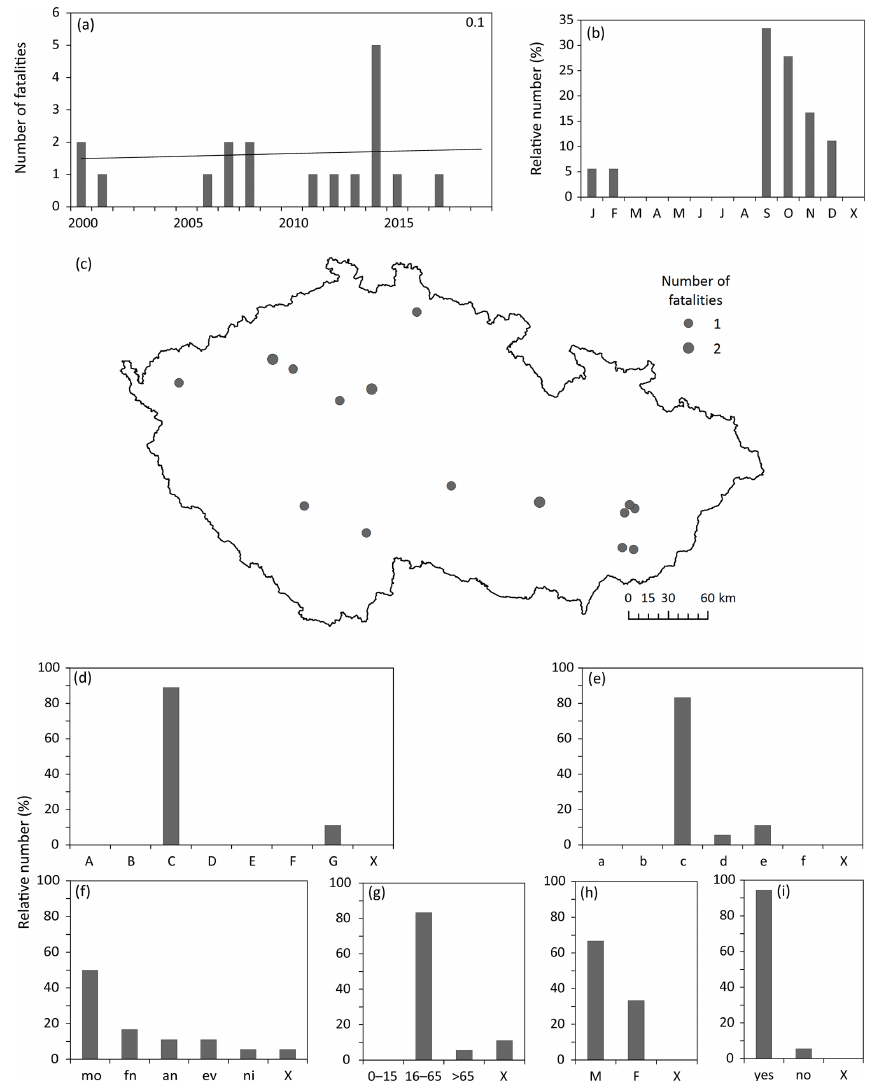
Figure 9. Characteristics of fog-related fatalities in the Czech Republic during the 2000–2019 period: (a) fluctuation with linear trend (top right, fatalities/10 years), (b) annual variation, (c) spatial distribution, (d) cause of death, (e) place of death, (f) part of the day, (g) age, (h) sex, (i) behaviour. For explanation of symbols and abbreviations see Fig.